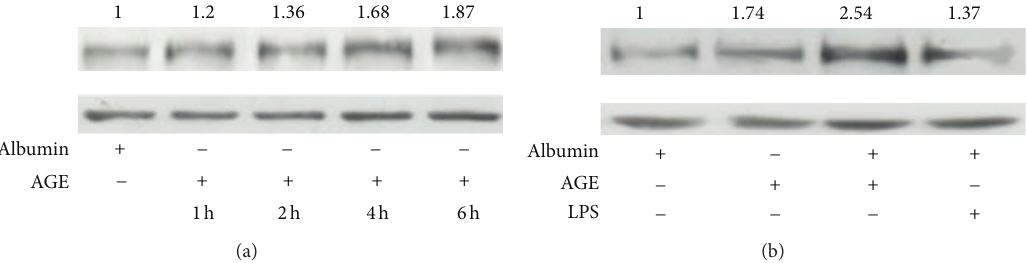
Figure7:AGEandLPSinduceHIF-1 𝛼 upregulationandcooperatetoover-increaseHIF-1 𝛼 expression.(a)AGEinducesHIF-1 𝛼 upregulation. (b) LPS induces HIF-1 𝛼 upregulation and synergizes with AGE to over-increase HIF-1 𝛼 expression. Equal protein loading was confirmed by probing with an anti- 𝛽 -actin antibody. Normalized density ratio of HIF-1 𝛼 over 𝛽 -actin is indicated for each